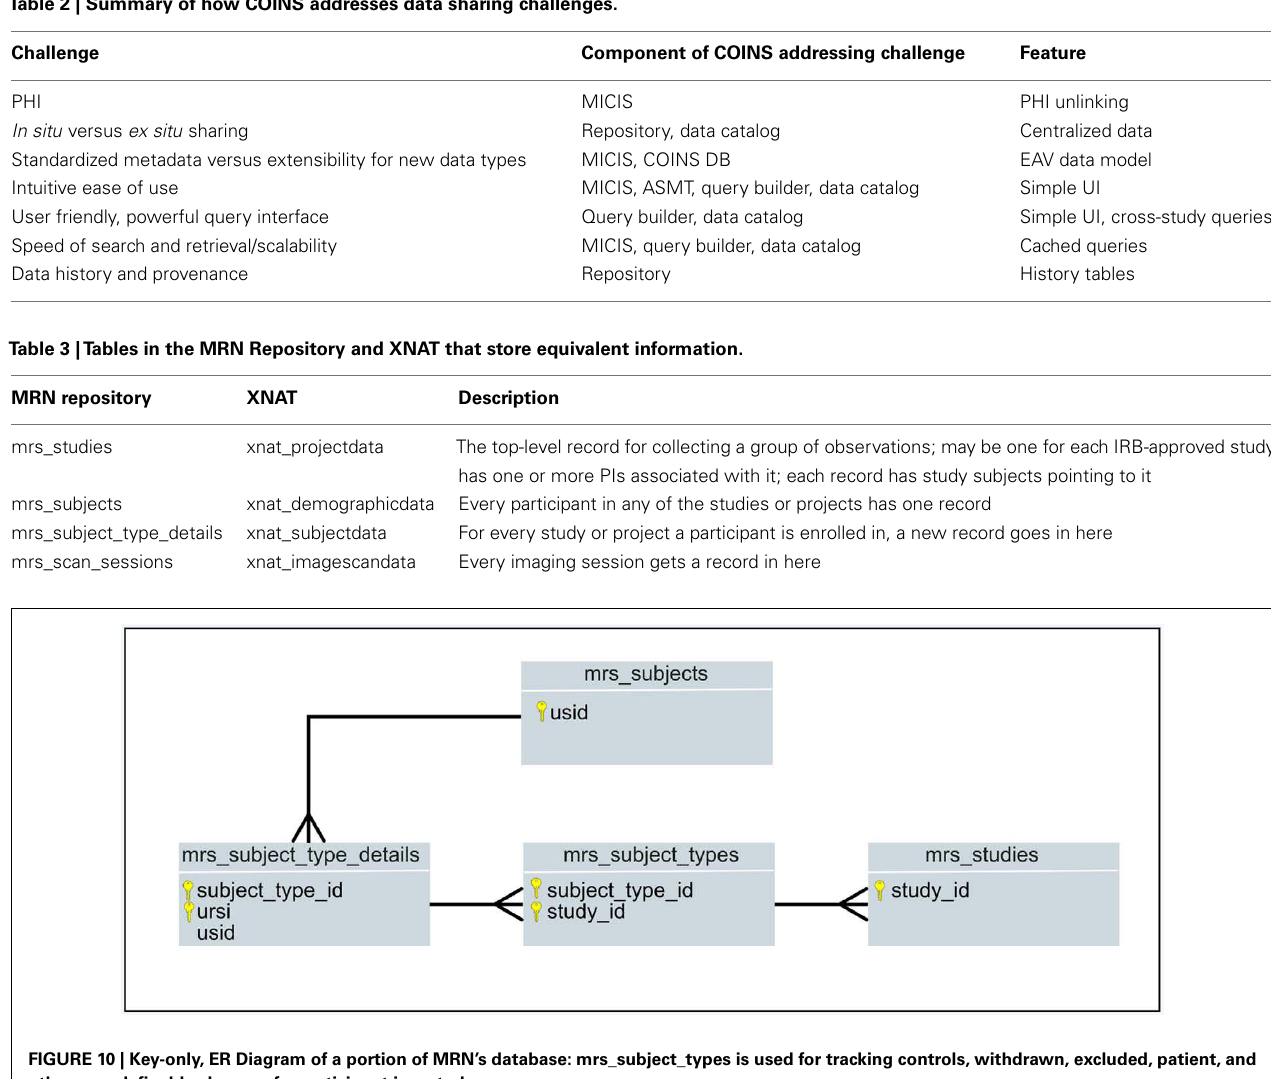
Table 2 | Summary of how COINS addresses data sharing challenges.